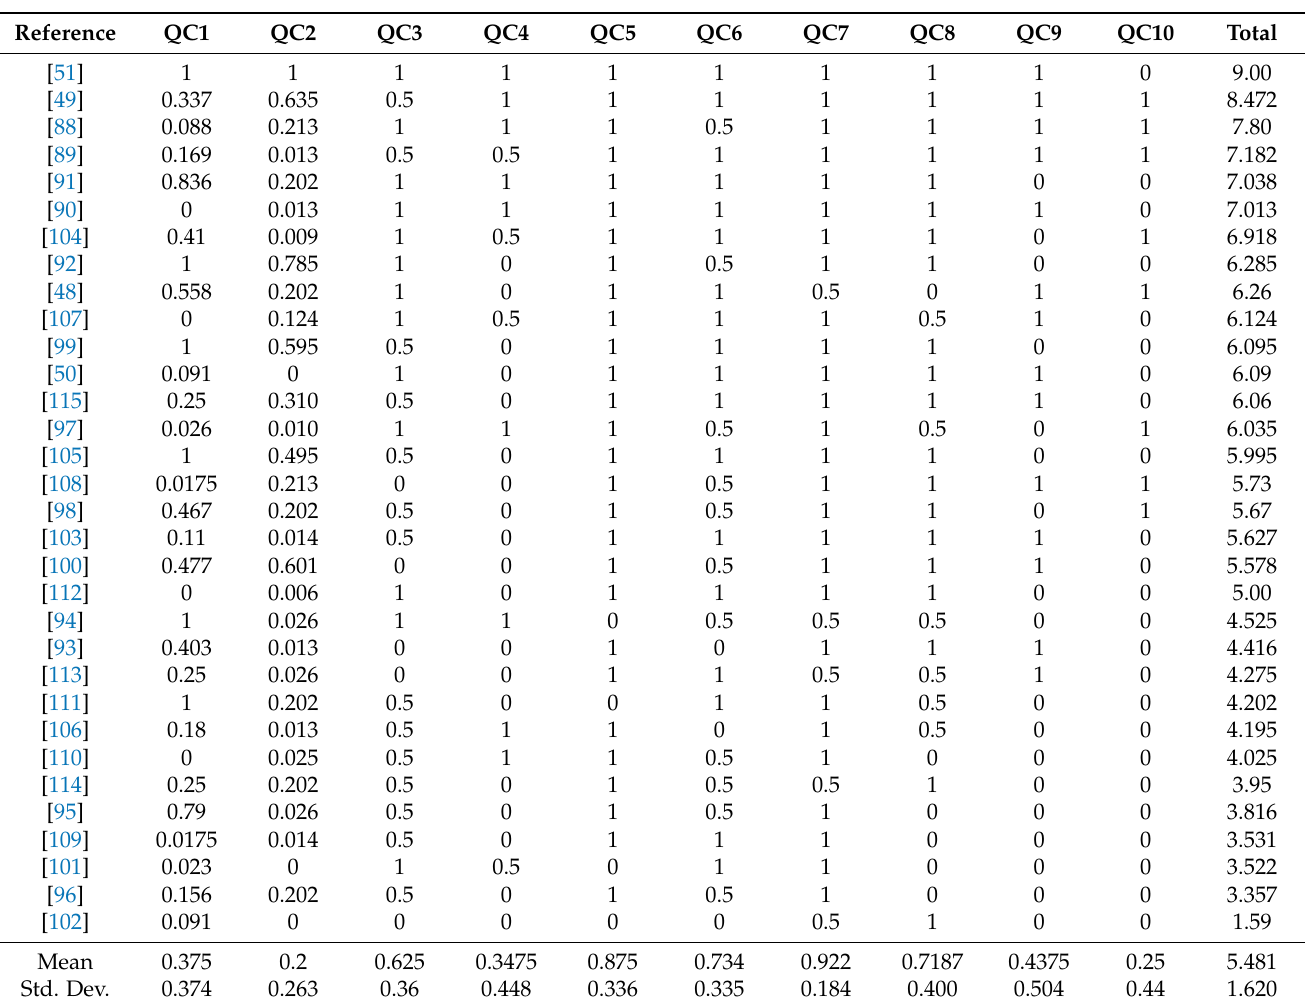
Table 8. Papers’ quality